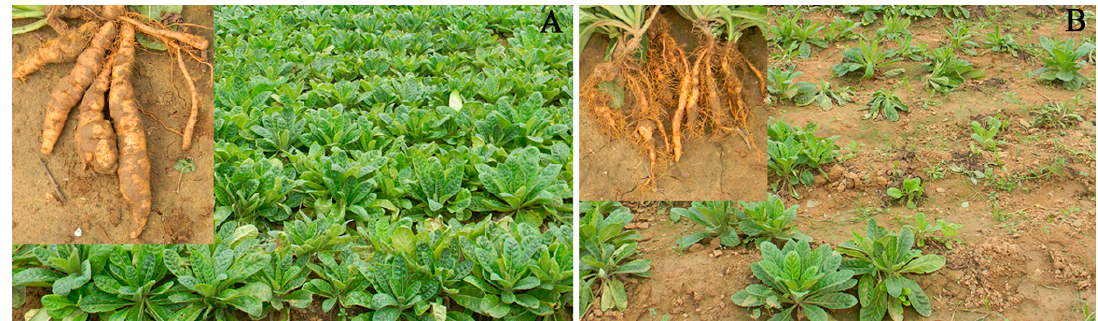
Figure 1. Photographs of above and below ground components of R. glutinosa under one-year ( A ) and two-year ( B ) consecutive monoculture.